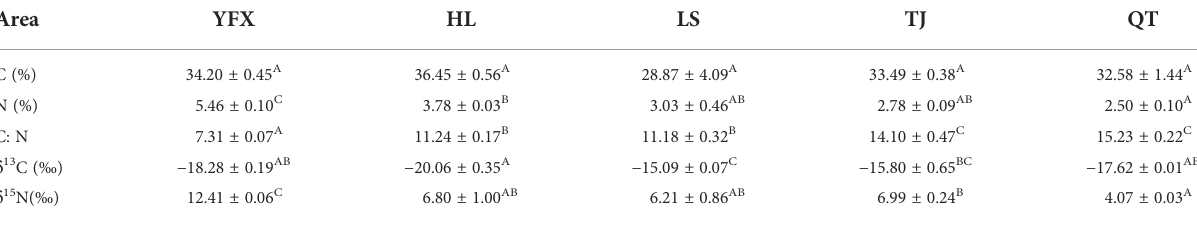
TABLE 2 Carbon, Nitrogen Content, Stable Isotope Analysis ( d 13 C and d 15 N) of seagrass tissue in fi ve meadows (Mean ± SE).